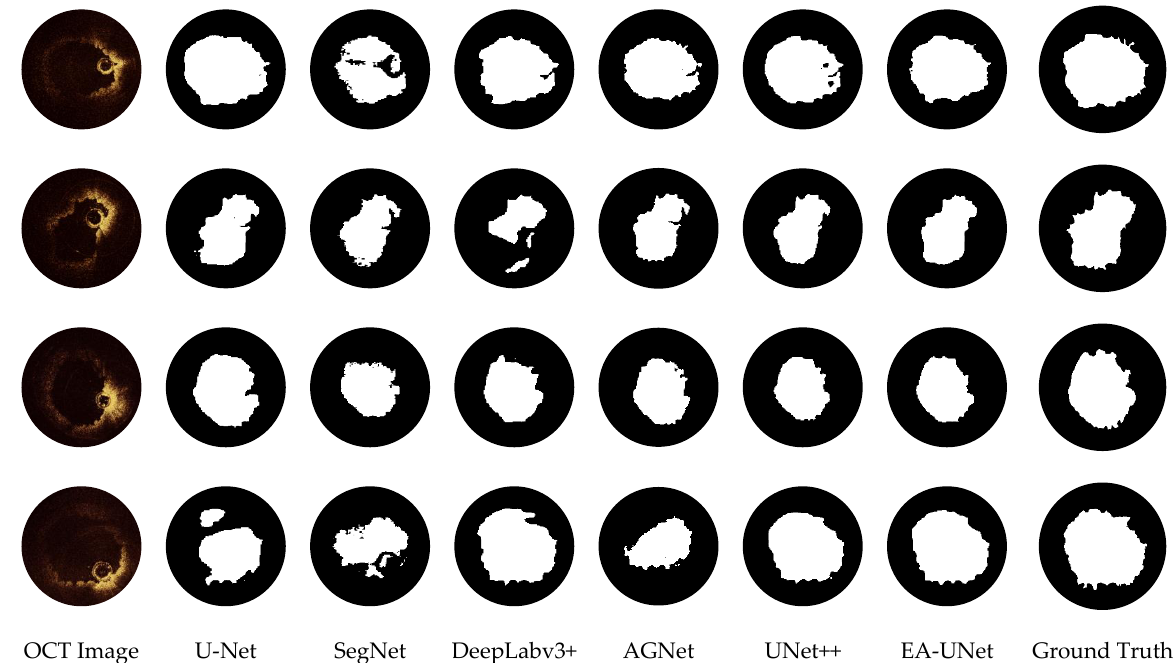
Photonics 2023 , 10 , x FOR PEER REVIEW Figure 7. Comparison of segmentation effects of different methods. Figure 7. Comparison of segmentation effects of different methods.